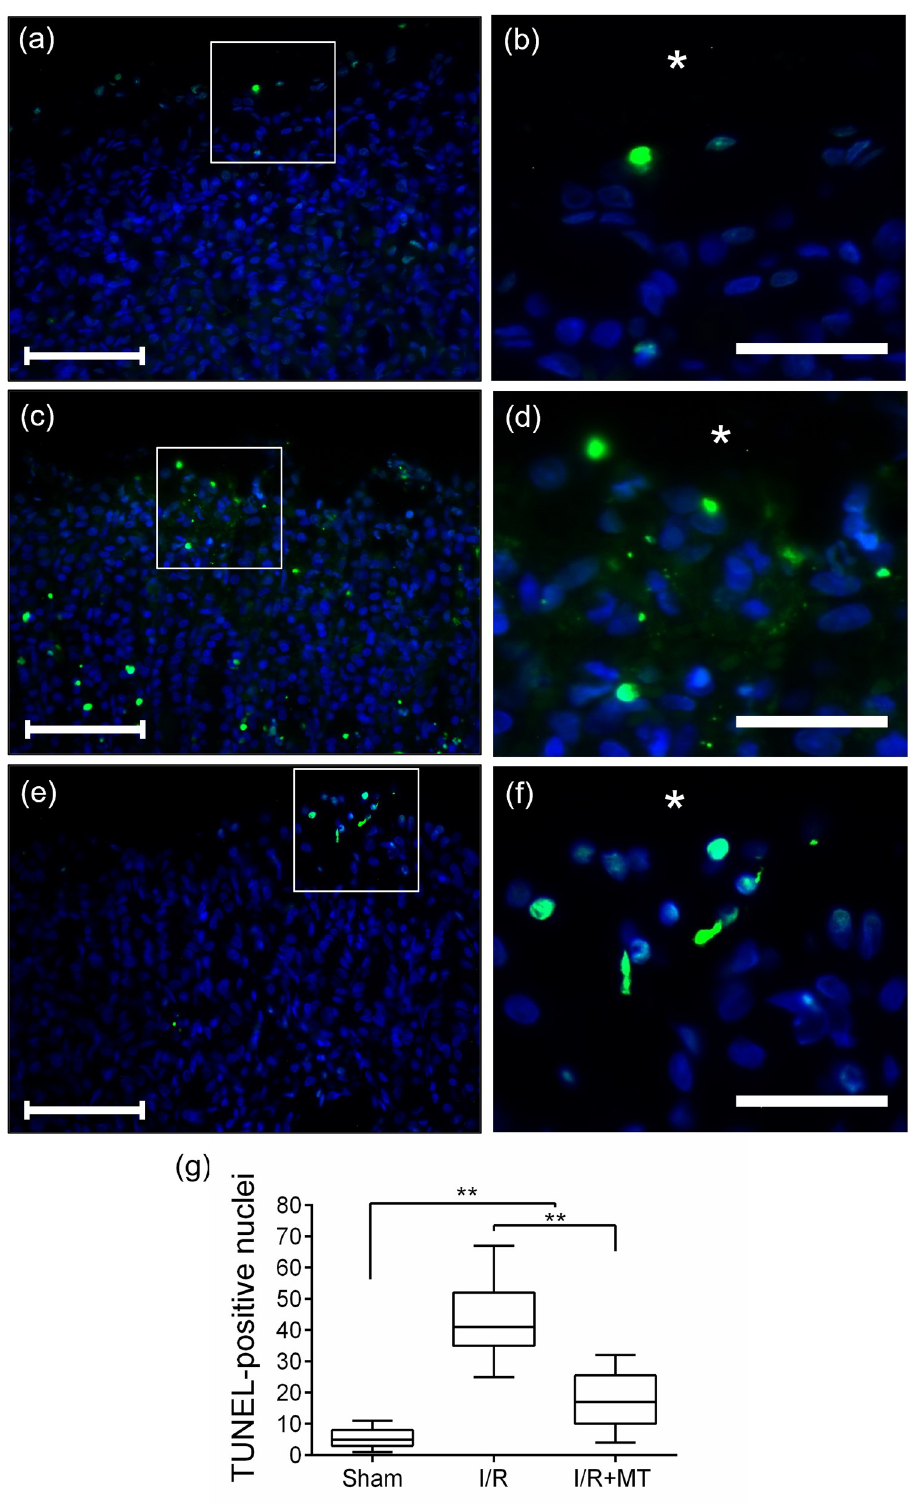
Fig 7. Effect of MT on apoptosis in experimental groups. Representative photomicrographs of TUNEL (Terminal dUTP Nick-End Labeling) apoptosis assay (a) to (f). Identifiers: (Framed area) TUNEL-positive cells, ( ⁎ ) gastric lumen. (a). Scale bar: 100 μ m (a), (c) and (e). Magnification: Scale bar: 50 μ m (b), (d) and (f). Graphic representation of